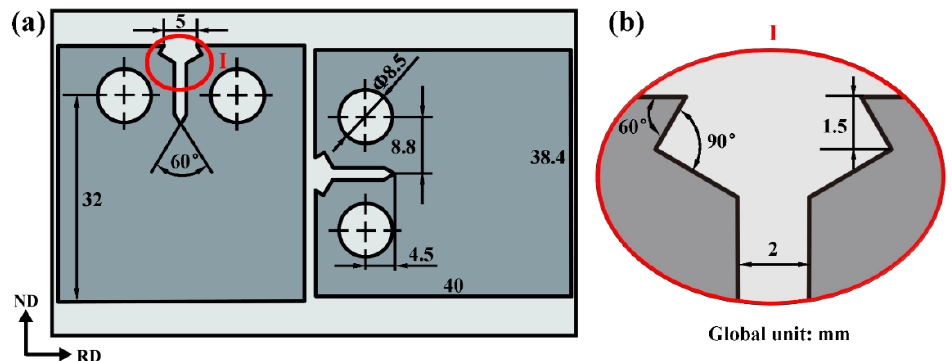
Figure 2. The schematic diagrams of CT specimens: ( a ) the CT specimen size; ( b ) the enlarged view of area I in ( a ).